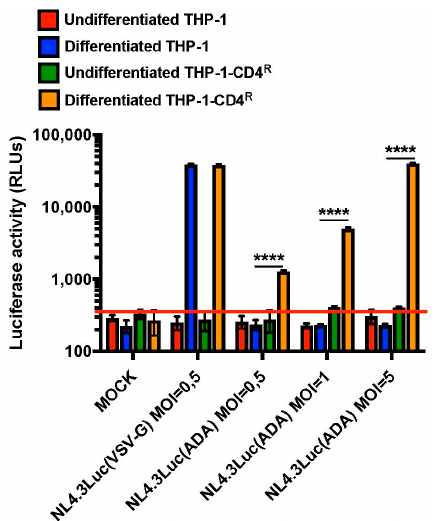
Figure 6. Differentiated THP-1-CD4 R cells are susceptible to CD4-dependent, HIV-1 infection. **** p < 0.0001. Control THP-1 or THP-1-CD4 R cells were either PMA-differentiated or not and infected with either VSV-G (MOI = 0.5) or HIV-ADA-Env (MOIs of either 0.5, 1 or 5)-pseudotyped Luciferase-encoding NL4-3 Env-negative Luc viruses. Luciferase activity was then measured in the cell lysates and expressed as relative light units (RLUs) ( n = 3; means ± SD are shown and compared using Student’s t test). The red line indicates background level. ‘MOCK’ corresponds to uninfected cells.